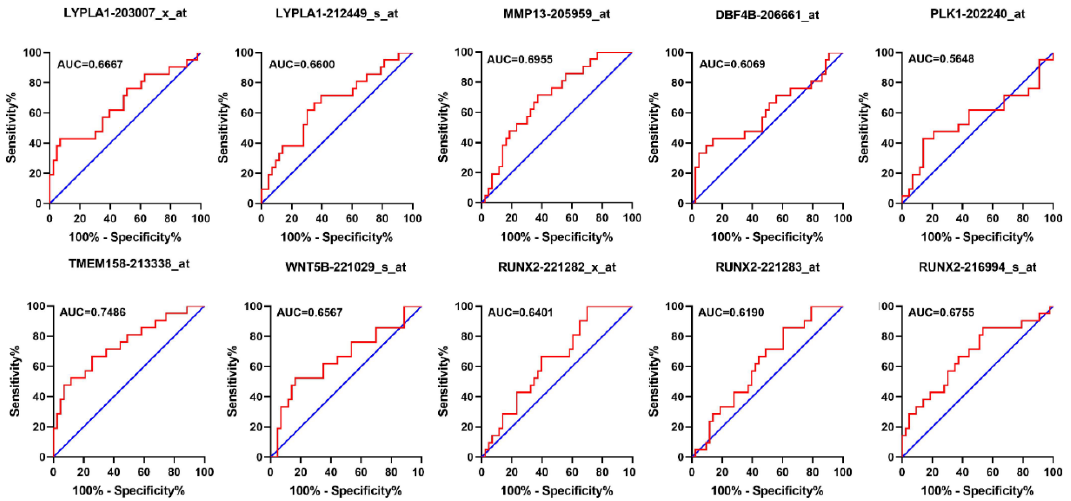
Figure 6. The ROC analyses of overall survival for LYPLA1 (203007_x_at, 212449_s_at), MMP13 (205959_at), DBF4B (206661_at) , PLK1 (202240_at), TMEM158 (213338_at), WNT5B (221029_s_at), RUNX2 (221282_x_at, 221283_at, 216994_s_at) according to transcription data in GSE72545. ROC: receiver operator characteristic, AUC: area under the curve.